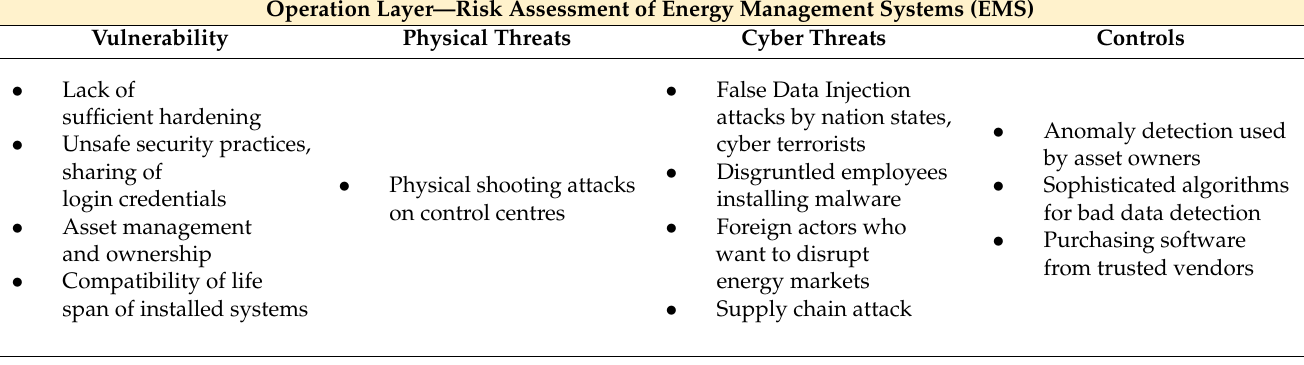
Table 12. Risk assessment of Energy Management Systems